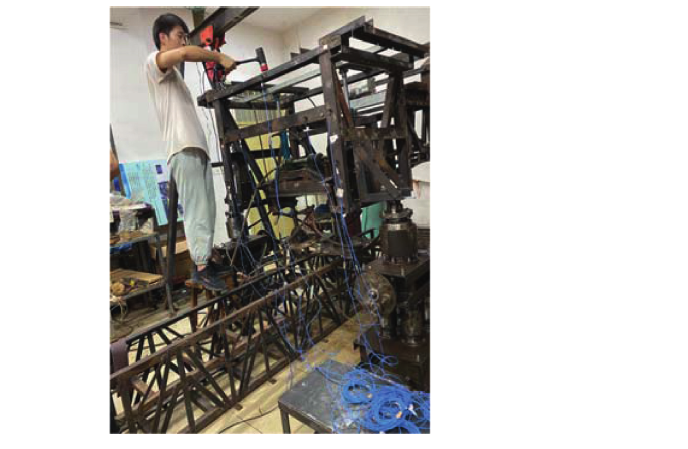
Figure 12: The SHEP with three-axis acceleration sensors pasted on it knocked with the force hammer.